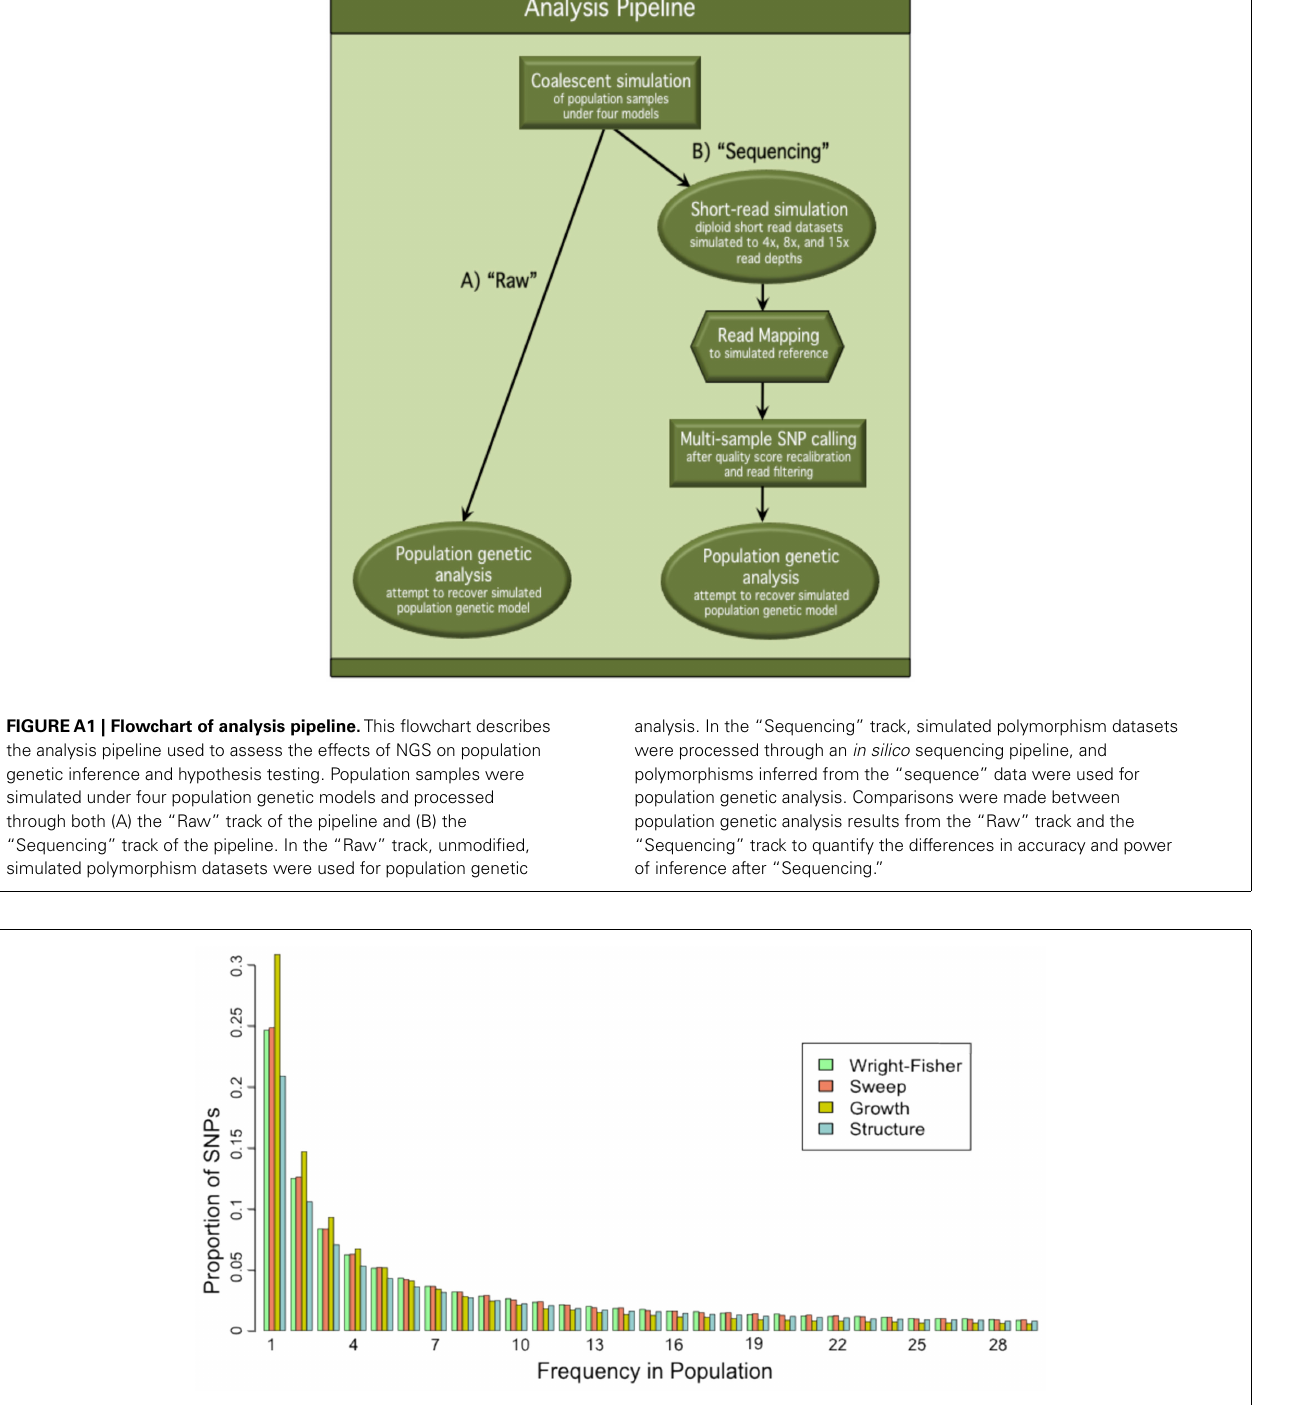
FIGUREA2 | Site-frequency spectrum from “complete” data for each population genetic model. The proportion of all true SNPs at various frequencies in the population is presented. For the structure model, frequency was calculated across both subpopulations (60 chromosomes) and